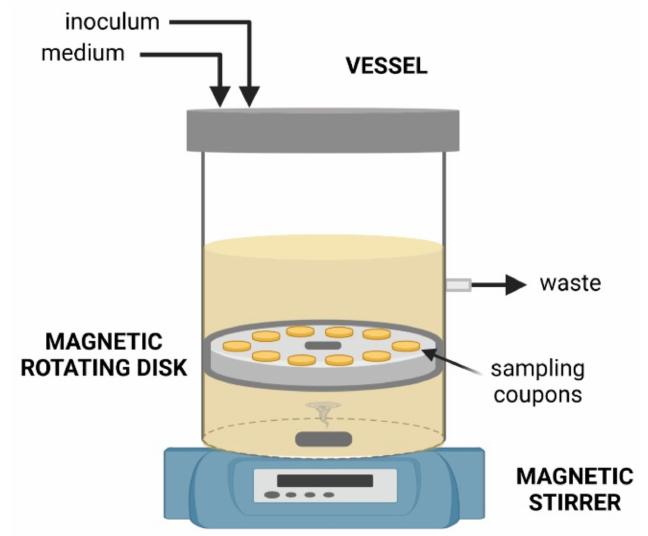
Figure 3. Scheme of a rotating disk reactor.